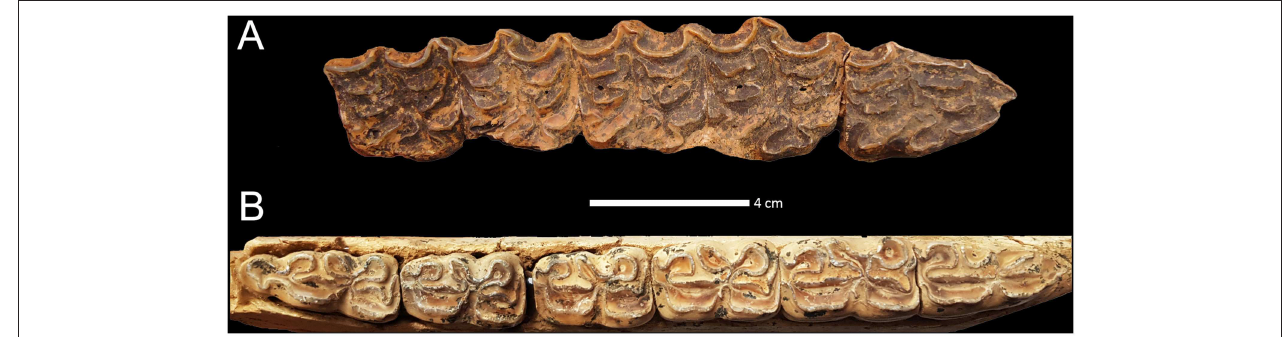
FIGURE 6 | Equus mosbachensis tautavelensis from lower level Q (CMI) of Arago cave. (A) Right maxillary with P4-M3 (G13-GEQ1-1290); (B) Right mandibular with P2-M3 (I8-IZPQ3-2160). Occlusal length of upper P3 (A) is about